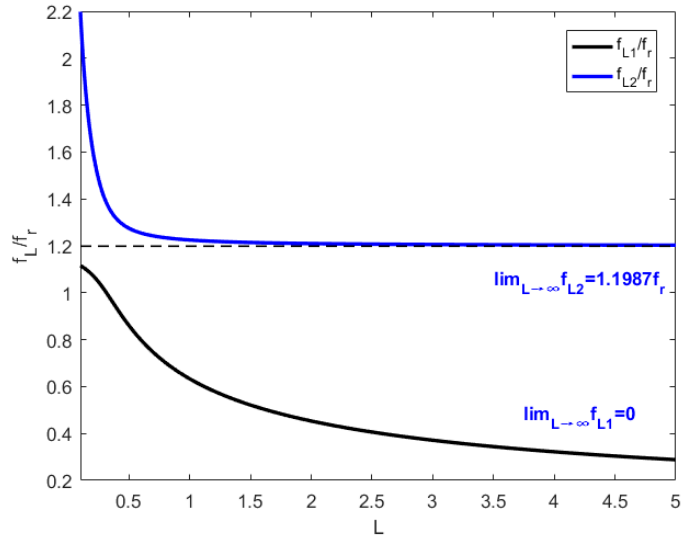
Figure 15. The changes of f L1 and f L2 with inductance increasing. Substitute the parameter L = 0.642 H into Equations (53) and (54), f L2 equals 1.1987 f r , and f r , equals 1775 Hz. According to Figure 15 as well as Equations (49), (50), (53), (54) and (A4)–(A6), the piezoelectric resonance frequencies f L1 and f L2 decrease as the increase of the inductance value and eventually